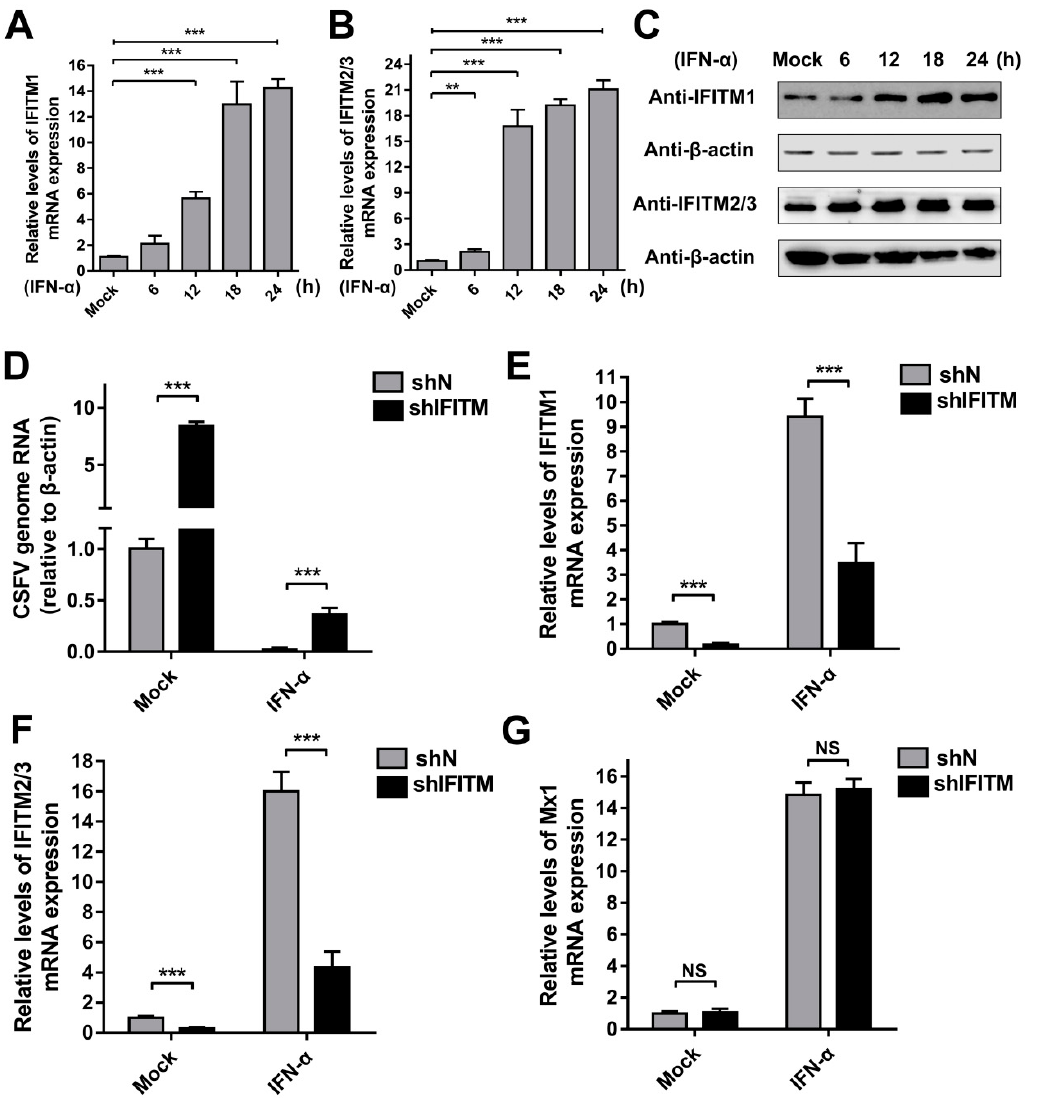
Figure 3. Expression of IFITMs is induced by interferon (IFN)- α treatment. RT-qPCR analysis of IFITM1 ( A ) and IFITM2/3 ( B ) mRNA levels (normalized to β -actin expression) in PAMs treated with IFN- α (10 ng/mL) at 6, 12, 18, and 24 h post-treatment (hpt). ( C ) Western blot analysis of IFITM expression in PAMs treated with IFN- α (10 ng/mL) at 6, 12, 18, and 24 hpt. β -actin served as an internal control. ( D ) CSFV genomic RNA in shIFITM cell lines with IFN- α pre-treatment. The shN and shIFITM cell lines were pre-treated with IFN- α and then infected with CSFV at an MOI of 1. CSFV genomic RNA levels were determined by RT-qPCR at 24 hpi. Data were normalized to β -actin expression. RT-qPCR analysis of IFITM1 ( E ), IFITM2/3 ( F ) and Mx1 ( G ) mRNA levels (normalized to β -actin expression) in shN and shIFITM cells. Data ( A , B , D , E – G ) represent the mean ± SD of three independent experiments and were measured in technical duplicate. Comparisons between groups were performed by Student’s t test. ** p < 0.01 and *** p < 0.001